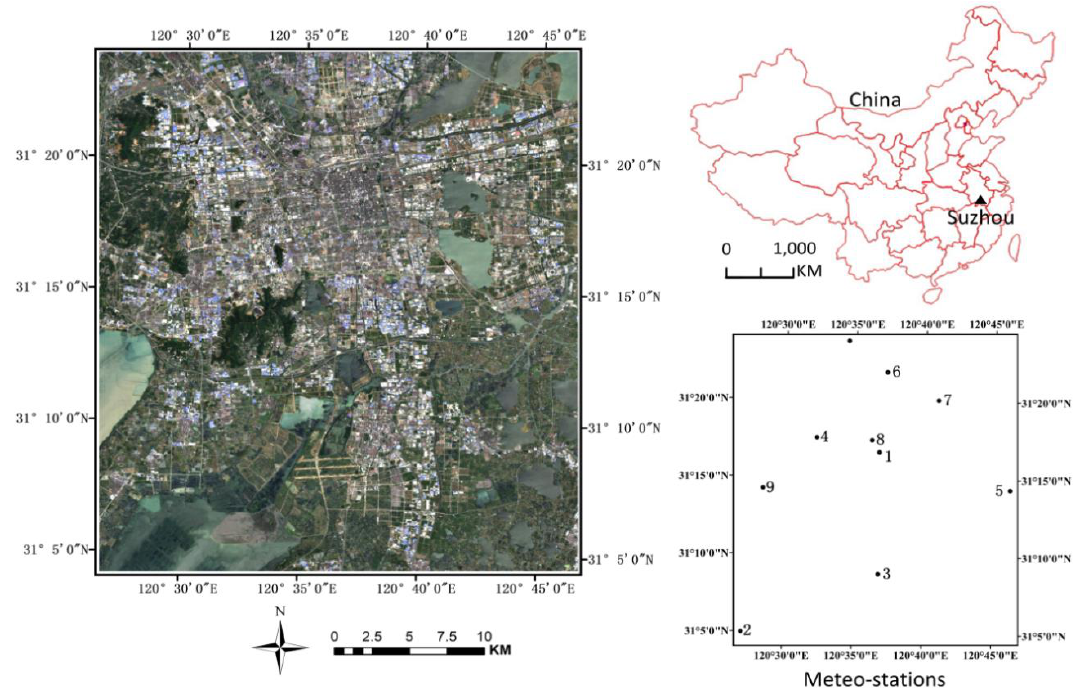
Figure 1. The left map is Landsat-5 TM true color composition imagery acquired over Suzhou city; the top right is the location of Suzhou in China, and the bottom map is for the meteorological stations, the number of which corresponds to that listed in Table 1.